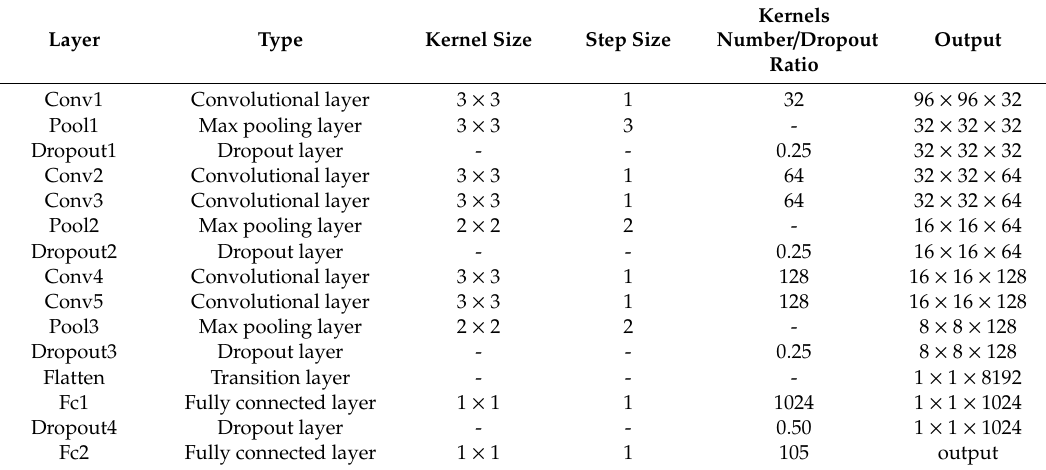
Table 1. The parameters of the layers in lightweight